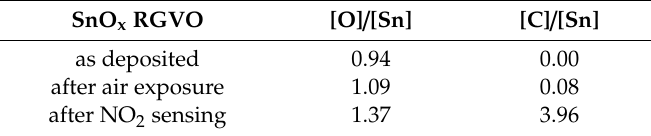
Table 1. Relative concentrations of the main components of RGVO SnO x nanolayers as deposited, after air exposure as well as and after NO 2 sensing